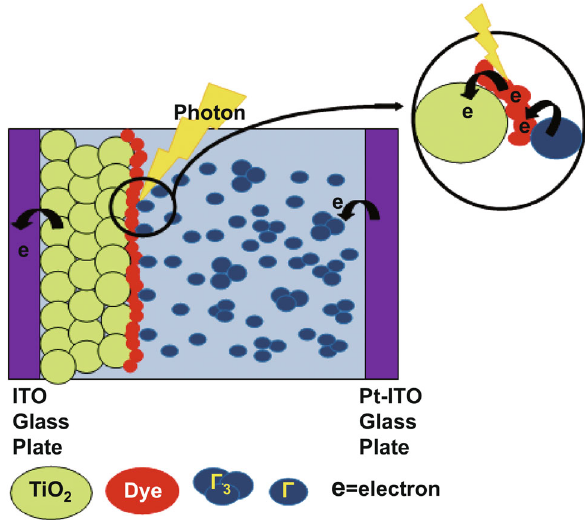
Fig. 3 Working principle of dye-sensitized solar cells